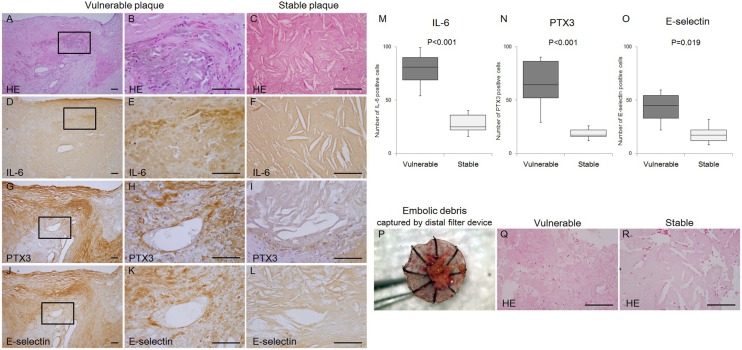
Immunochemical staining of atherosclerotic carotid endarterectomy specimens and emboli captured by distal protection devices.Serial sections were stained with hematoxylin and eosin (HE) (A, B, C, Q, R), anti-IL-6 (D, E, F), anti-PTX3 (G, H, I), and anti-E-selectin (J, K, L) antibodies. Sections from CEA (A to L), quantification of immunohistochemistry analysis of IL-6, PTX3, and E-selectin staining of sections from CEA (M, N, O), and embolic debris from CAS captured by the distal filter device (P, Q, R) are shown. HE staining showed inflammatory cell infiltrations in the vulnerable plaques (A, B, Q) and cholesterin crystals in the stable plaques (C, R). IL-6 staining is observed in the vulnerable plaques with inflammatory cell infiltration (D, E) but not in the stable plaques (F). PTX3 expression is observed in endothelial and perivascular cells and in the basement membrane in the vulnerable plaques (G, H) but not in the stable plaques (I). Immunohistochemistry revealed E-selectin expression in endothelial cells in the vulnerable plaques (J, K) but not in the stable plaques (L). The second line on the left of the vulnerable plaques (B, E, H, K) shows enlargement of the cropped areas. Scale bar, 100 µm.